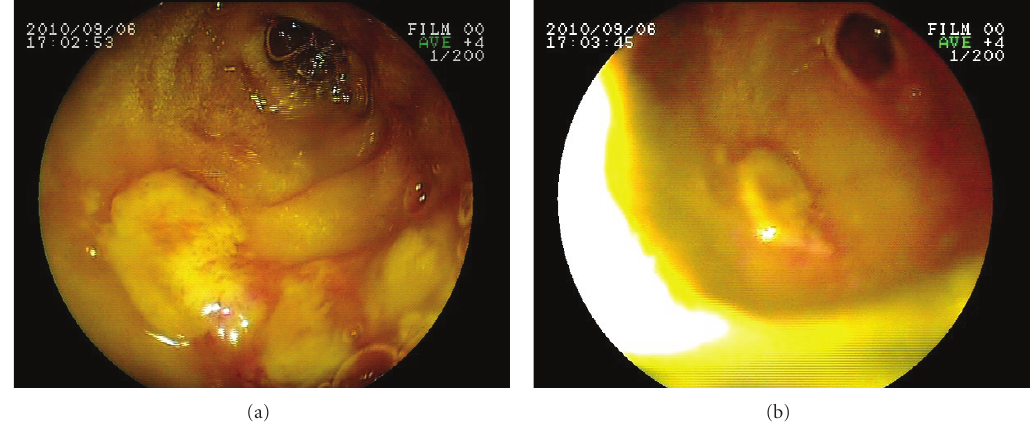
Figure 2: Endoscopic vision of the duodenal